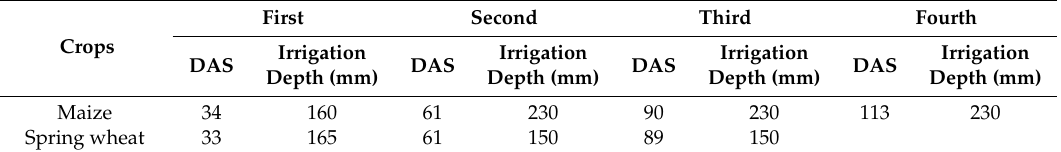
Table 3. Irrigation schedules for maize and spring wheat (DAS means days after sowing).